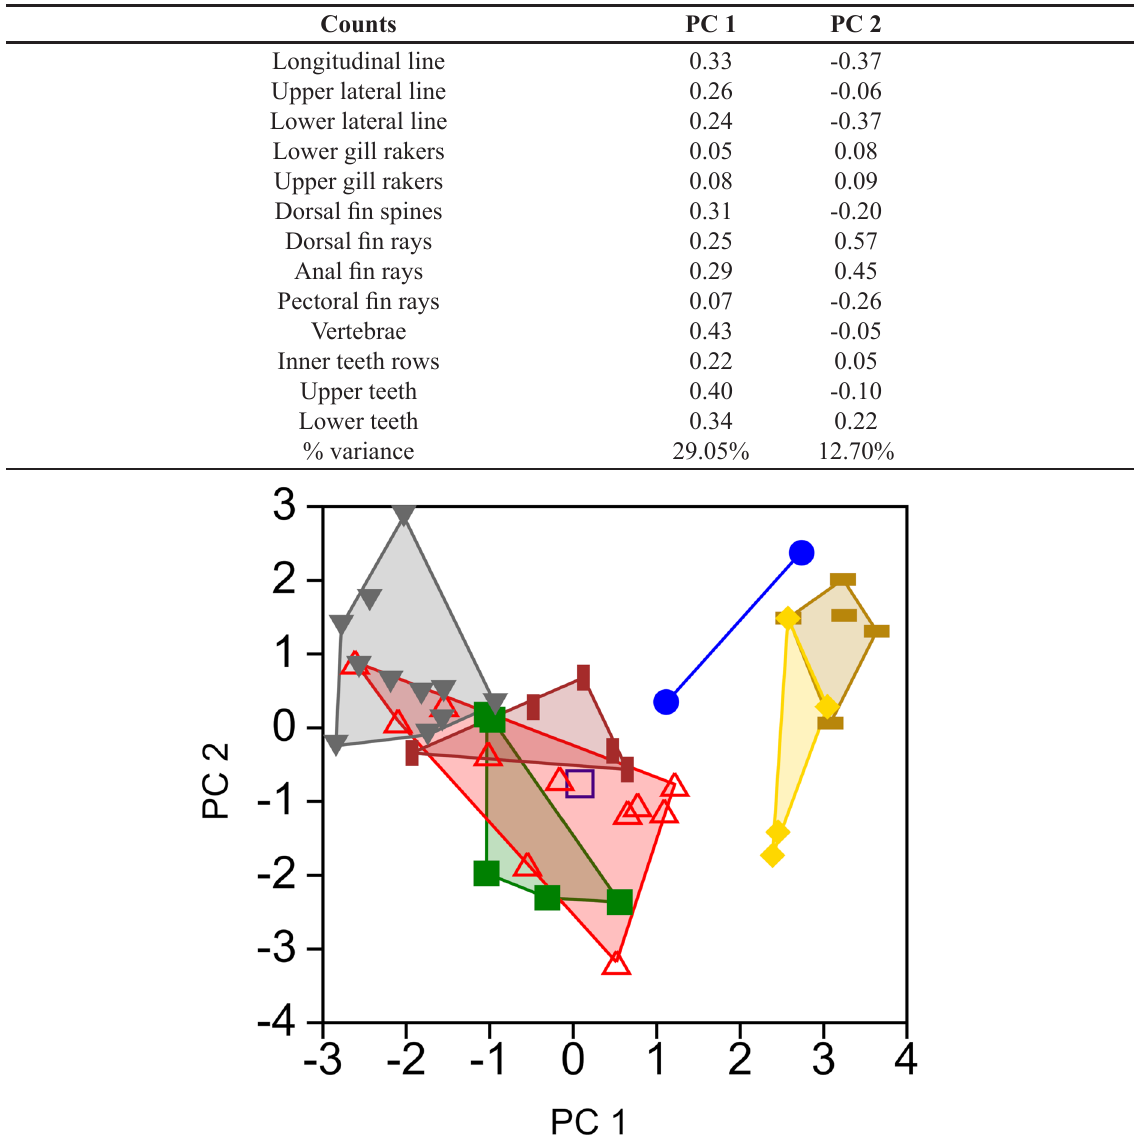
Fig. 3. Scatter plot of PC 1 against PC 2 for a principal component analysis of 13 counts of all specimens studied (n = 44). Protomelas krampus sp. nov. = blue dot; Hemitaeniochromis brachyrhynchus Oliver, 2012 = purple square; H. urotaenia (Regan, 1922) = green square; Hemitaeniochromis sp. ‘ insignis like’ = red triangle; P. spilopterus (Trewavas, 1935) = grey inverted triangle; P. insignis (Trewavas, 1935) = golden diamond; Caprichromis liemi (McKaye & Mackenzie, 1982) = light brown dash; C. orthognathus (Trewavas, 1935) = dark brown